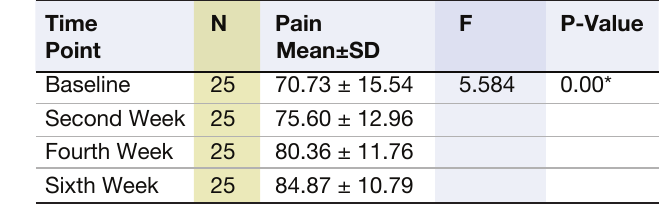
Table 8. Physical Function Scores of Participants in the Clinic Group across Baseline, Second, Fourth and Sixth Week of Intervention